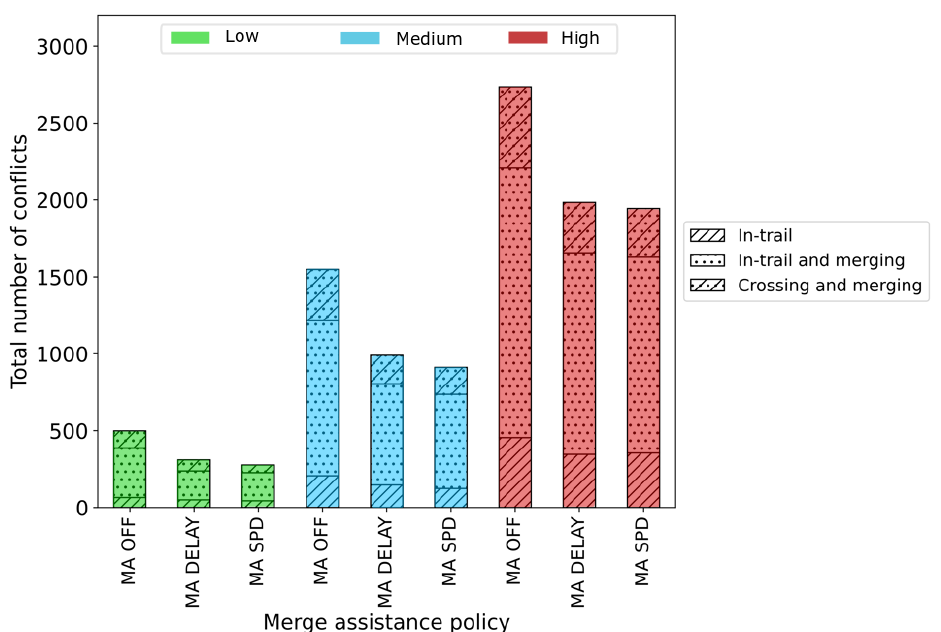
Figure 6. The total number of pairwise conflicts and their associated type with and without merge assistance for low, medium and high traffic demand. Note that MA OFF means without merge assistance. All three cases (MA OFF, MA Delay and MA SPD) also consider the effect of the tactical conflict